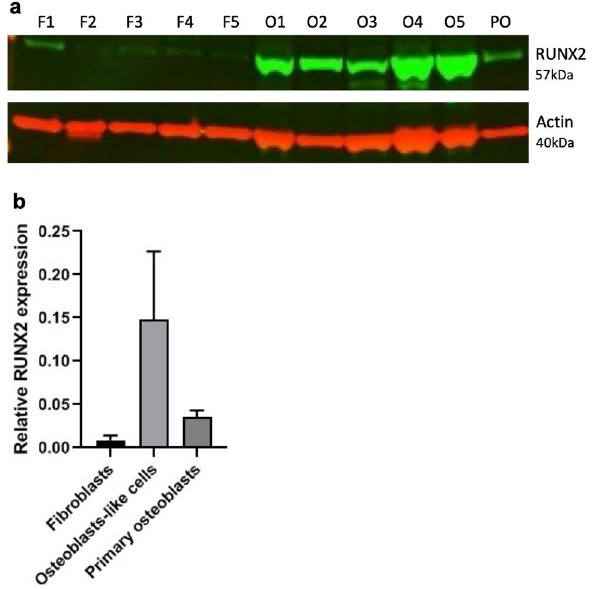
Figure 3. Western blot analysis of RUNX2 expression. ( a ) RUNX2 expression determined by western blotting analysis of fibroblasts from 5 healthy controls (F1-F5) and their transdifferentiated osteoblast-like cells on day 21 of osteogenic transdifferentiation (O1-O5) and primary osteoblasts (PO). Actin was used a loading control. ( b ) The western blot was also quantified. The full-length blot can be seen in supplemental Fig.